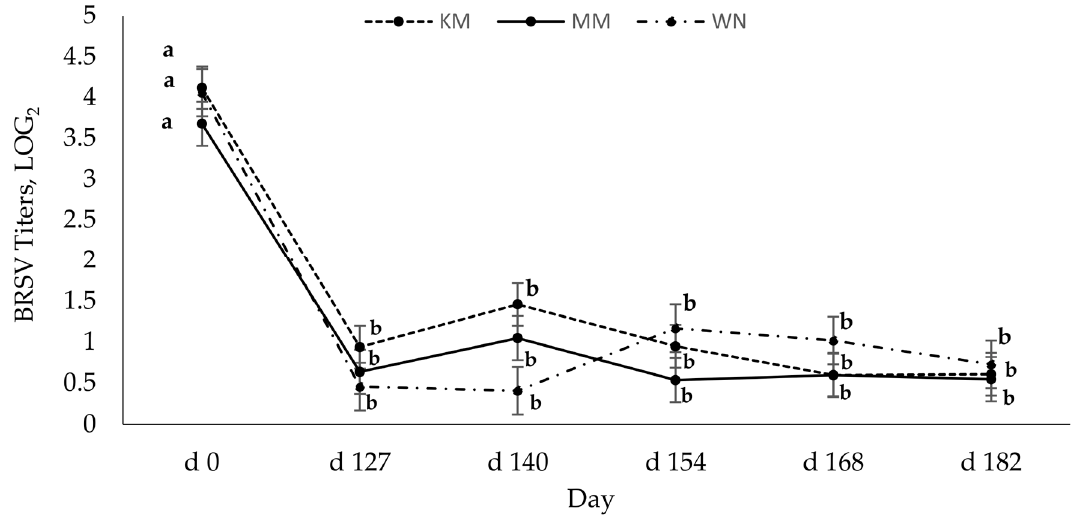
Figure 1. Least square means log 2 BRSV antibody titers by day for calves vaccinated with either an inactivated BRD vaccine on D 0 (2 to 3 months of age) and a modified live viral vaccine (MLV) on D 127 or an MLV administered at d 0 and d 127 (weaning), or an MLV vaccine on d 127 (weaning) and d 140 (13 days post-wean). D 0 represents colostral antibodies. a,b Least square means with differing superscripts differ ( p < 0.05). There was no effect of vaccination treatment or treatment x day interaction ( p > 0.08), but the day effect was significant ( p <